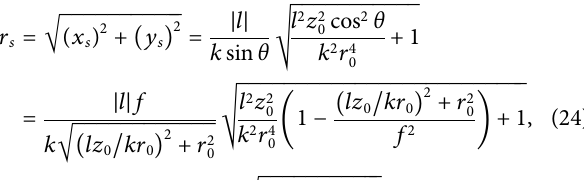
where sin θ = r ′ / f , and r ′ = is the pupil radius of the focusing lens. According to Eq. 24 , r s decreases with the increase in r 0 , which means that the maximum radius r 0 of the vortex beam in the plane z = 0 corresponds to the minimun ring radius r s of the focal spot. The intensity near the center of the focal spot is zero, and the shape of focal spot is similar to a donut.